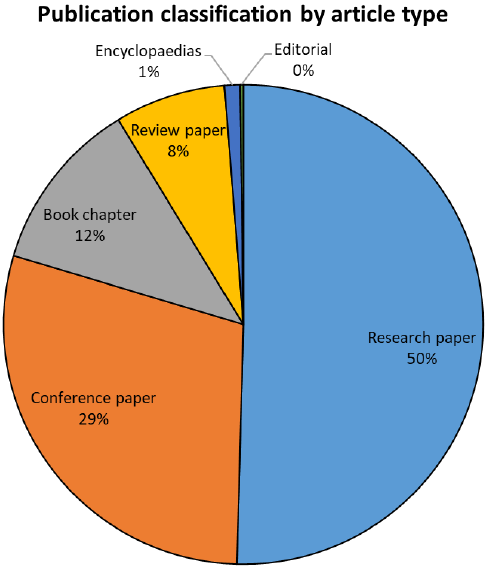
Figure 3. Distribution of publications by article type over the years.